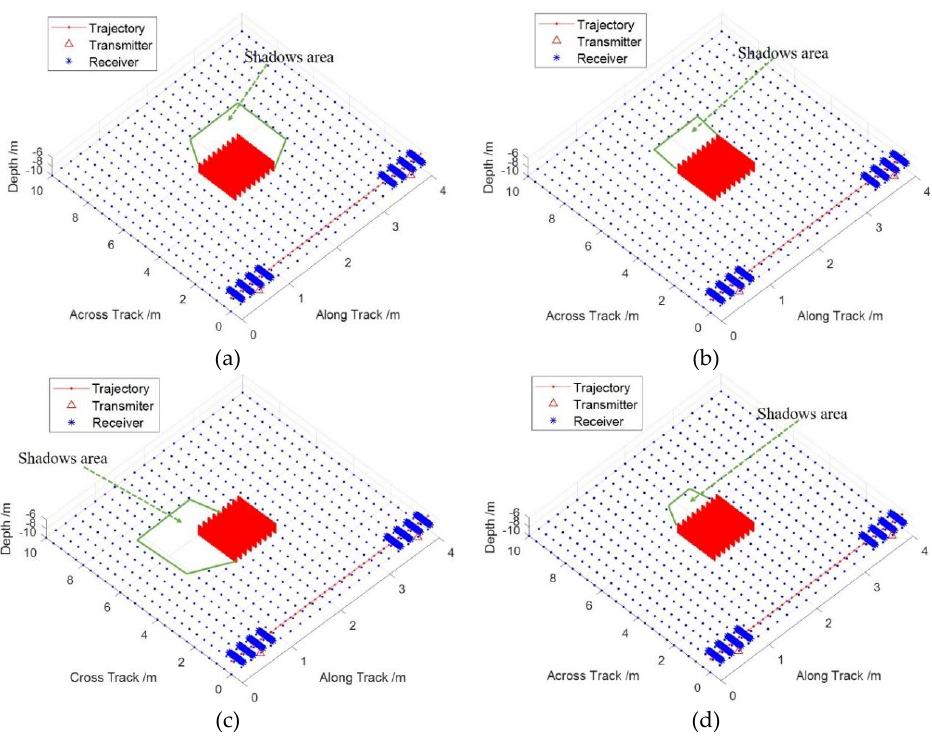
Figure 11. Target and shadow areas at different viewing positions: shadows at the ( a ) start viewing position; ( b ) middle viewing position; ( c ) end viewing position; and ( d ) final synthetic shadow area.